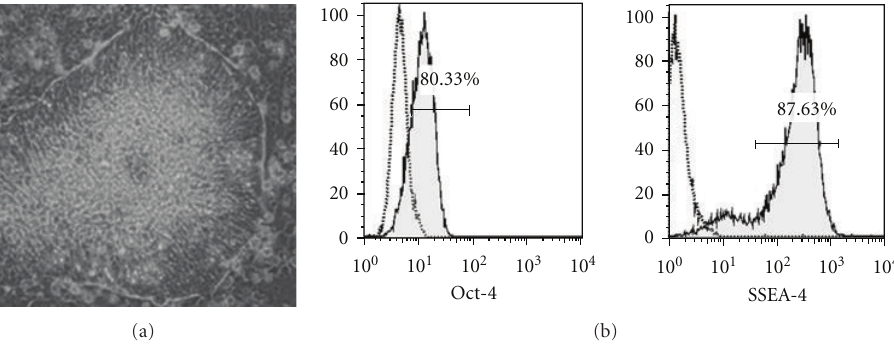
Figure 1: Maintenance of the H1 hESC line. (a) Colony of H1 hESC showing the morphology typical of pluripotent stem cells, including prominent boarders ( × 20 magnification). (b) Expression by H1 hESC of the transcription factor Oct-4 and the surface marker SSEA-4, both of which correlate with pluripotency. Dead cells were removed from flow cytometric analysis using 7-AAD staining. Open histograms represent appropriate isotype